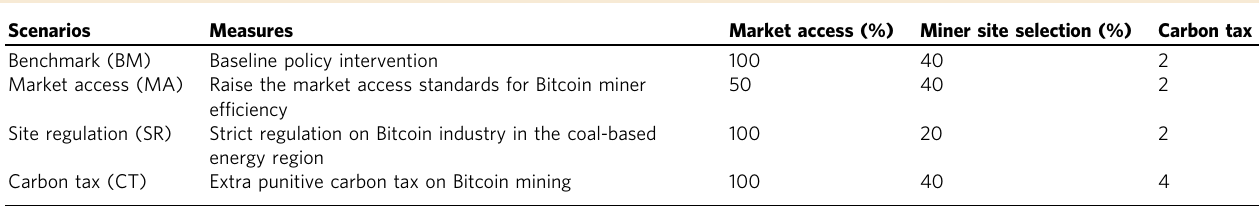
Note: Exogenous auxiliary parameters are introduced to assess the carbon emission fl ows under different Bitcoin policy measures. In terms of variable settings, three main parameters are chosen as the scenario factors in the proposed BBCE model, including market access (MA), miner site regulation (SR), and carbon tax